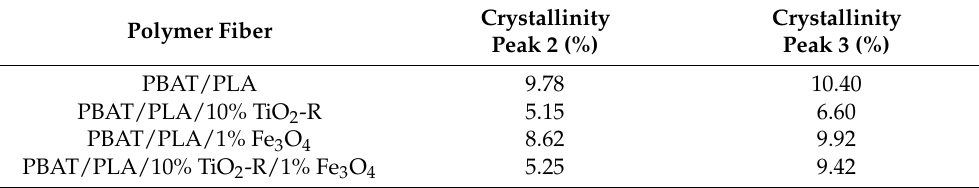
Table 6. Crystallinity percentages calculated for the melting peaks of the polymeric fibers. Polymer